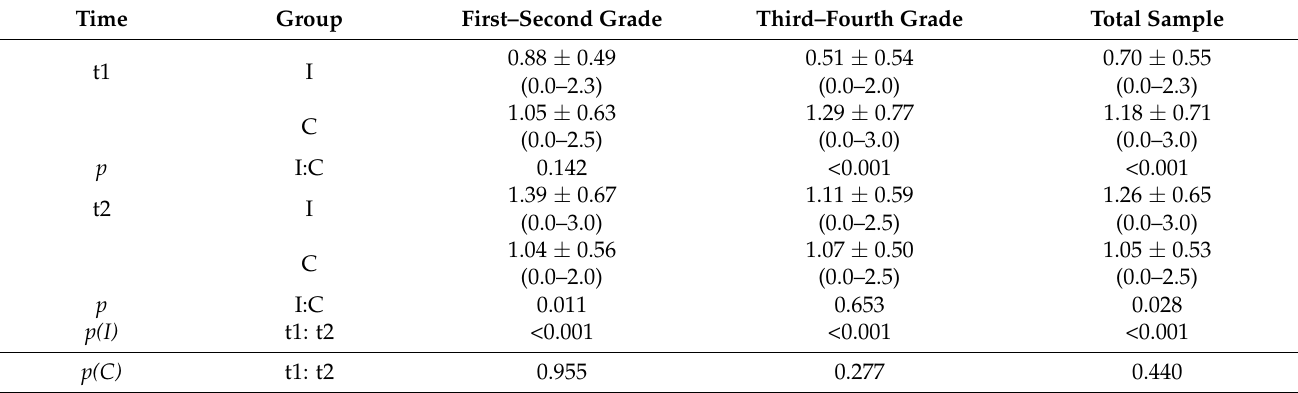
Table 2. Average intake of fruit (servings) in the I group and the C group in t1 and t2.